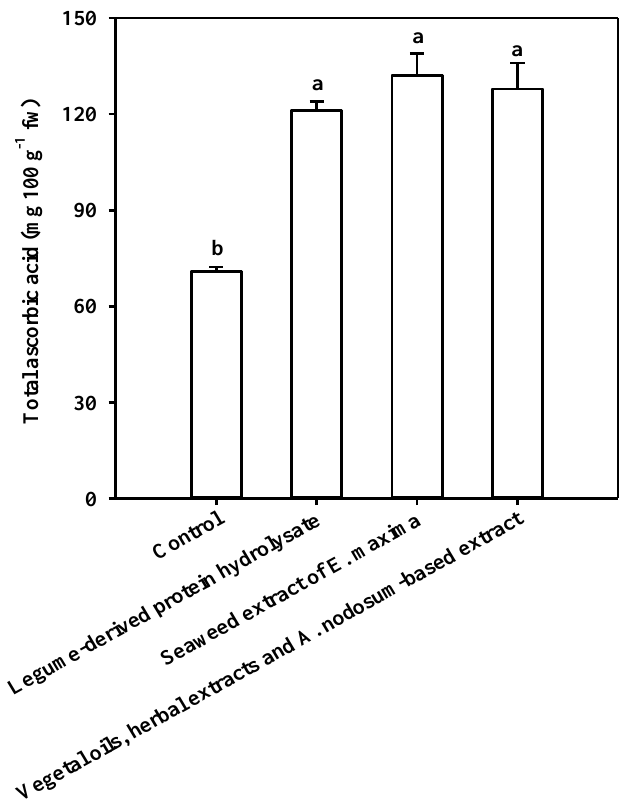
Figure 4. The effect of biostimulant treatments on ascorbic acid content of leaves in greenhouse spinach plants. The values are means of three replicates. Vertical bars indicate ± SE of means. Different letters indicate significant differences according to Duncan’s test ( p < 0.001).